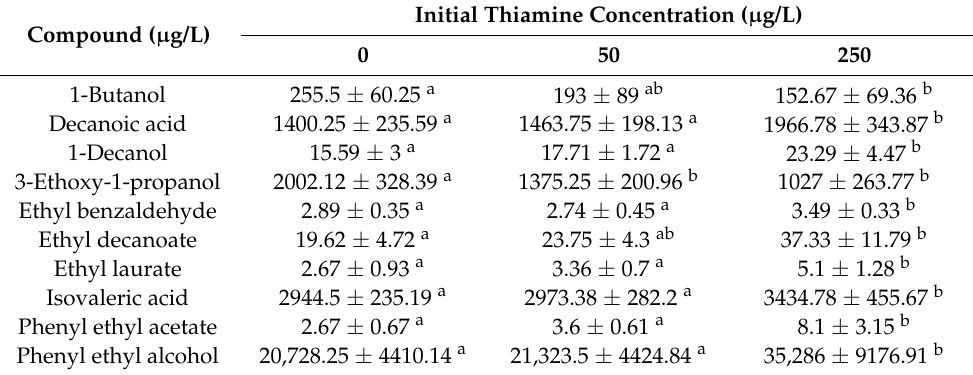
Table 7. Thiamine-dependent volatile contents in the final